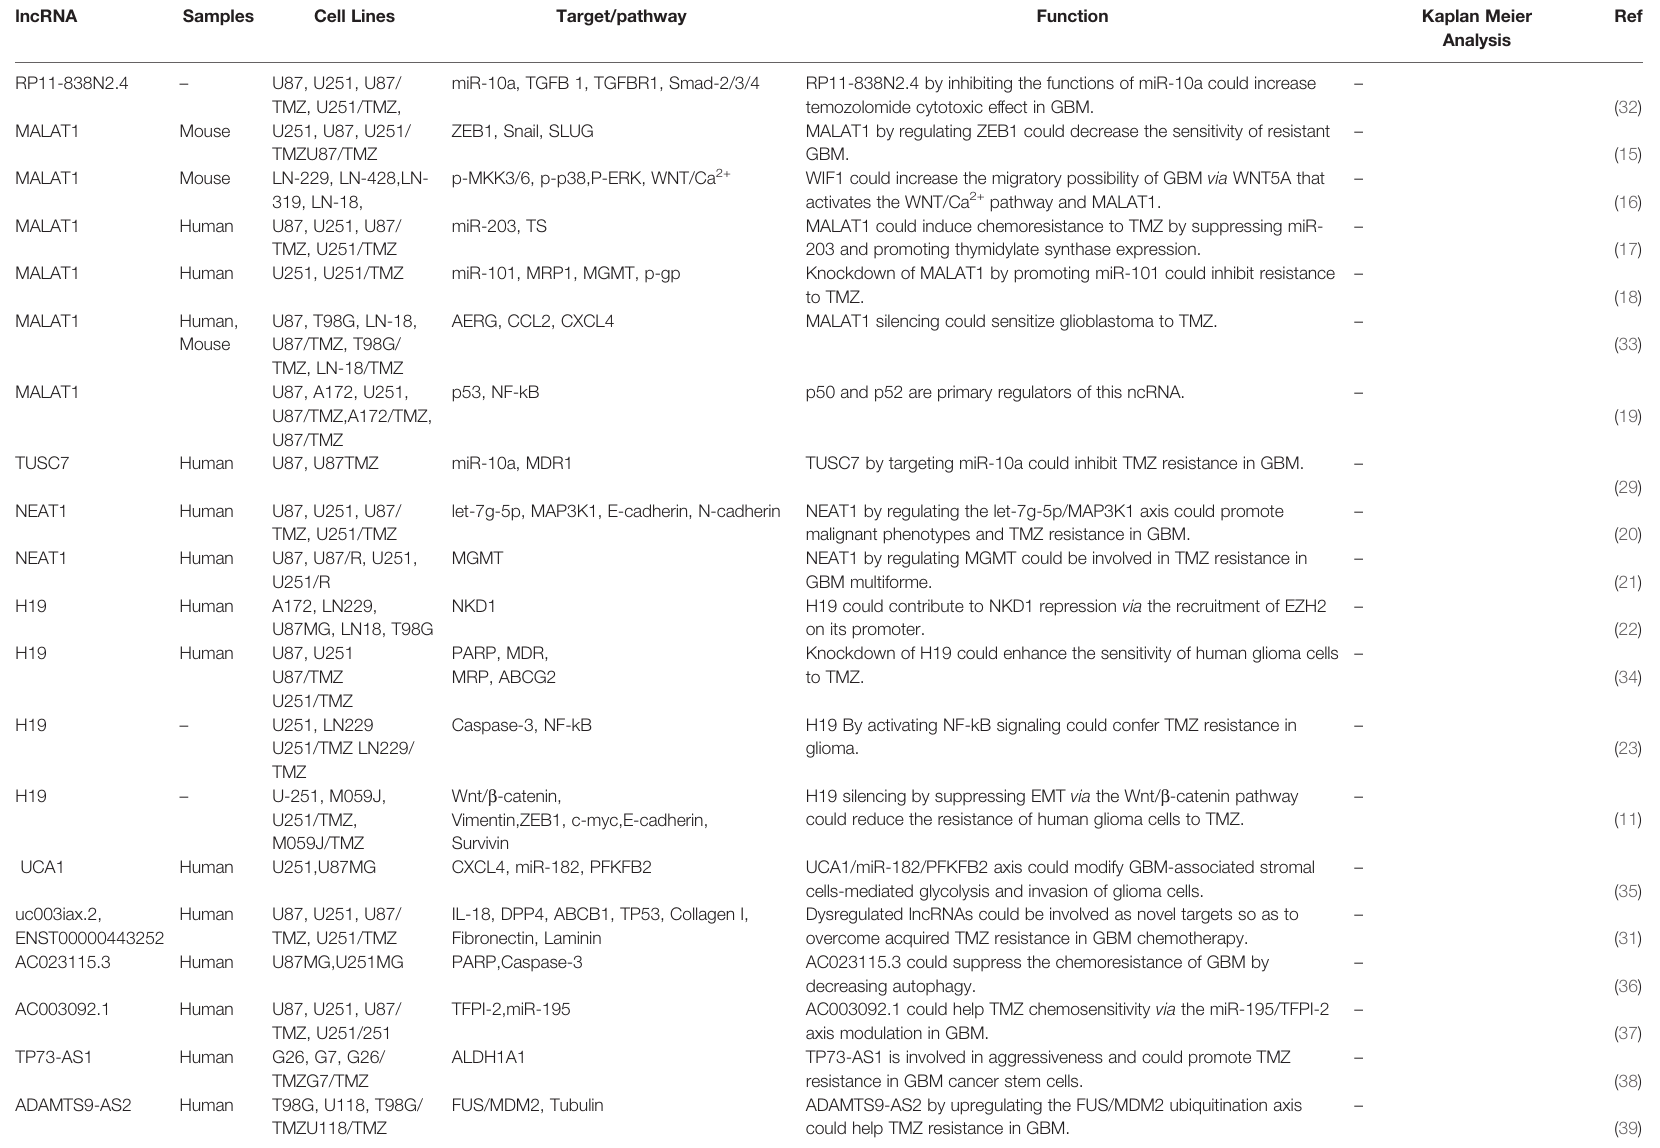
TABLE 1 | LncRNAs that modulate the response of glioblastoma/glioma to chemotherapy.